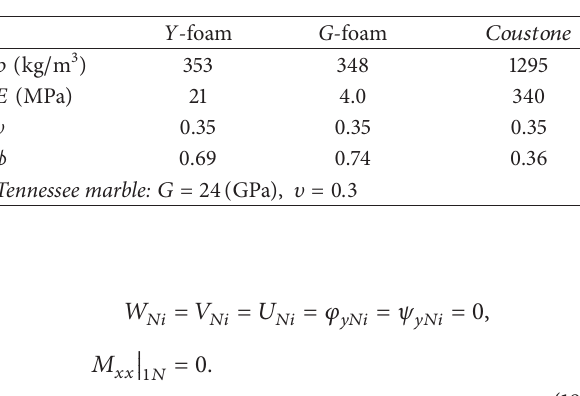
Table 2: Mechanical properties of porous materials.